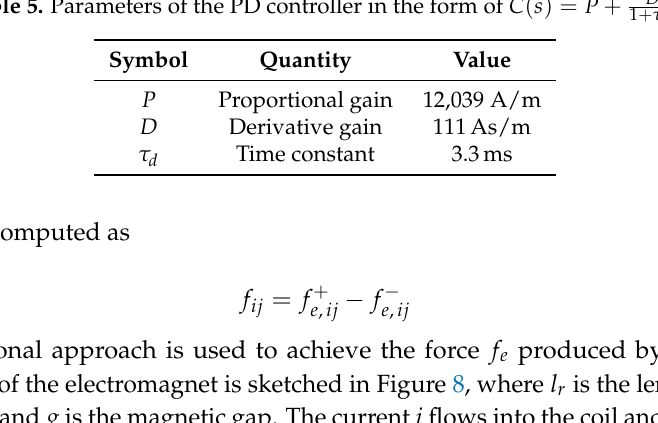
Table 5. Parameters of the PD controller in the form of C ( s ) = P + D